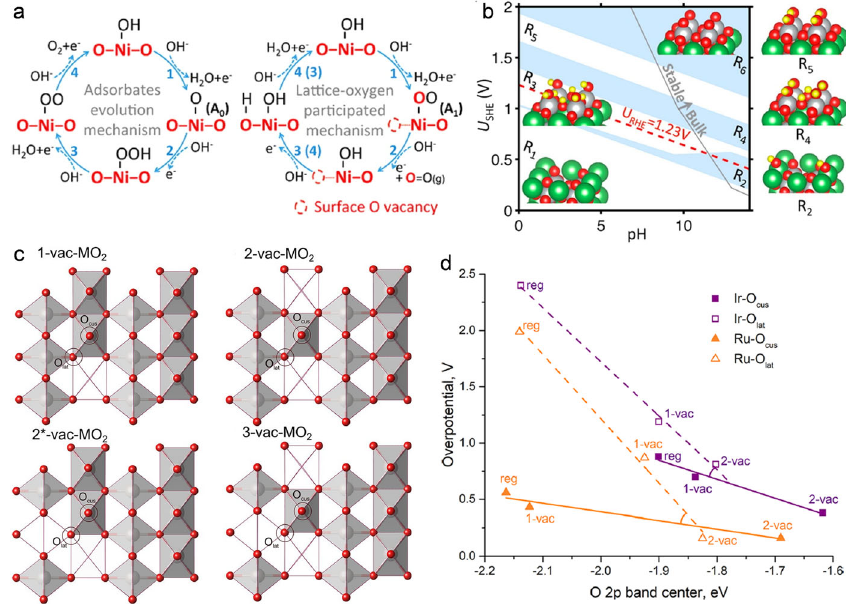
Fig. 5 Types of OER and relation between OER activity and O p -band center. a Schematics of AEM and LOM. b Computed surface phase diagram relevant to AEM for LNO in aqueous solution. Surface structures are labeled in each colored region ( a and b are reproduced with permission from ref. 166 , Copyright © American Chemical Society 2016). c Top view of the structural models for MO 2 (110) (M = Ru, Ir) containing one, two, and three M vacancies. White polyhedra depict the positions of vacancies. d Correlation between the computed OER overpotential and O 2 p -band center for AEM (solid line) and LOM (dashed line) for MO 2 (110) (M = Ru, Ir) surface ( c and d are reproduced with permission from ref. 174 , Copyright © American Chemical Society (Fig. 5b). For a range of perovskites ABO 3 (A = La, La 0.5 Sr 0.5 , Sr, and B = Mn, Fe, Co, Ni), OER prefers LOM for decreasing catalysts